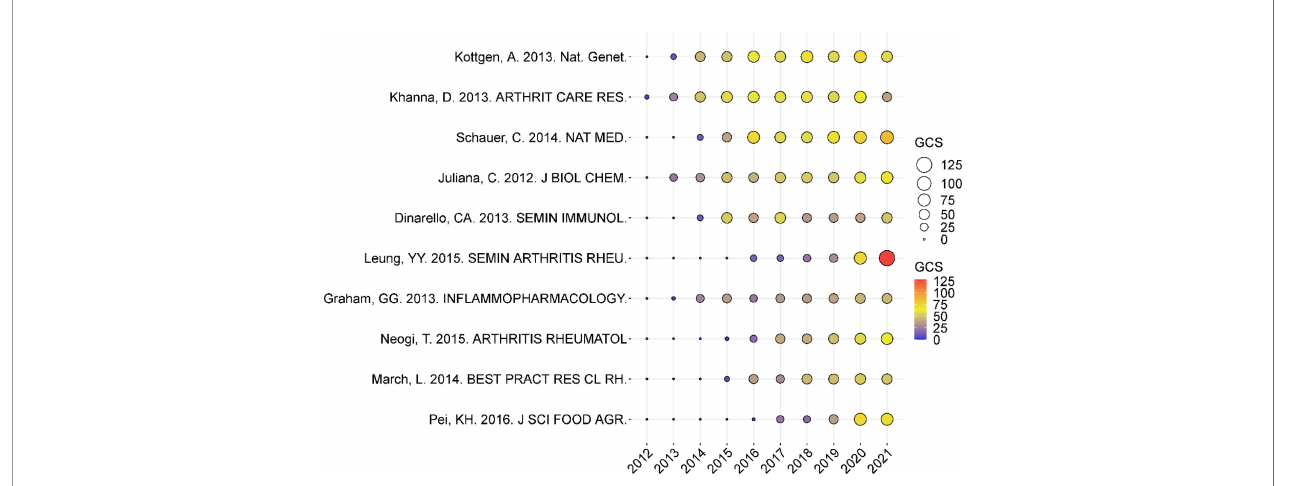
FIGURE 4 | The yearly number of global citations for papers having a high global citation score (GCS). The circle ’ s size and colours show the GCS of papers. The larger the circle and the colour from blue to red, the higher the GCS of the article and the more in fl uential it is in the fi